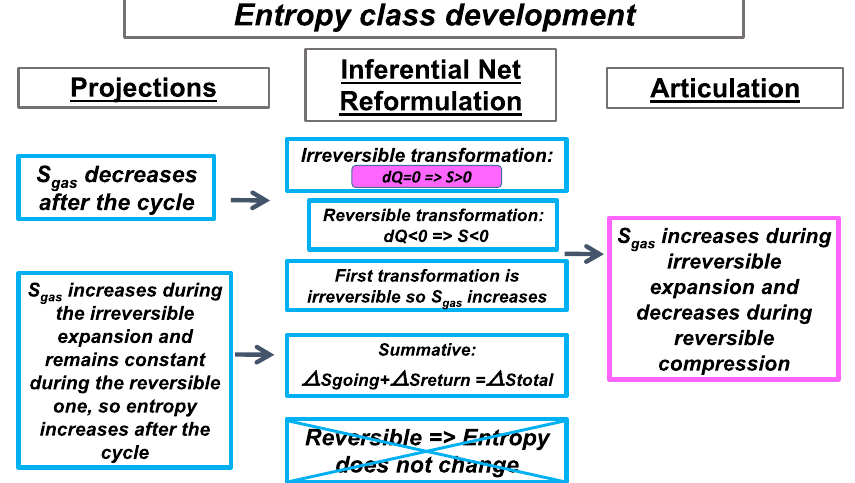
FIG. 8. Articulation diagram during the third segment. Purple highlight is used for contributions or changes proposed by both